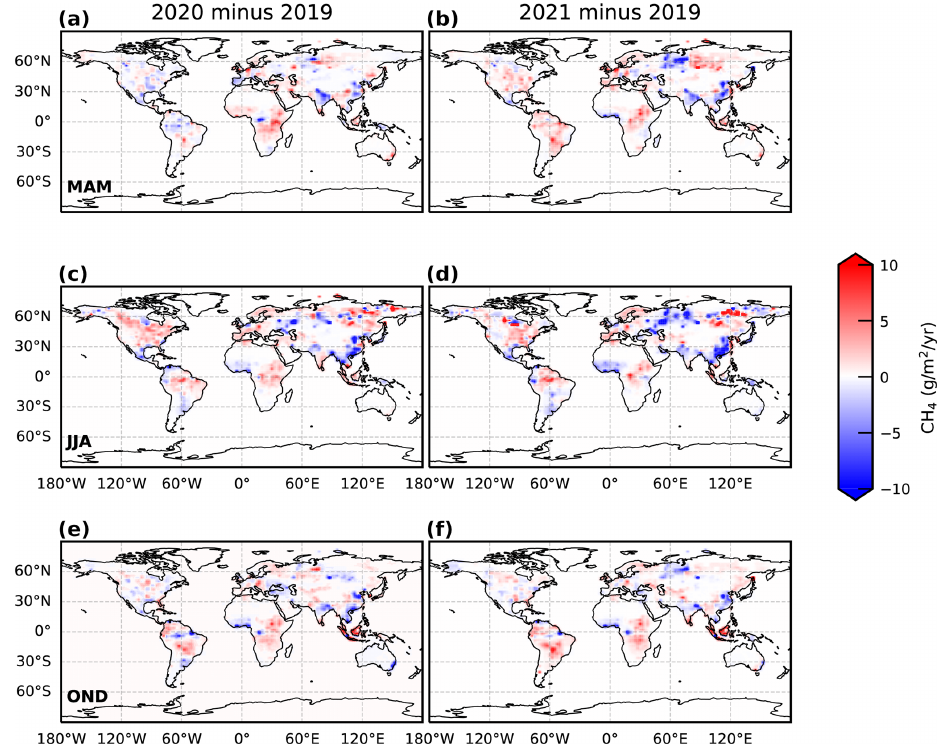
Figure A4. Global seasonal a posteriori emissions of methane (gm − 2 yr − 1 ) inferred from GOSAT methane:CO 2 column ratio data for (a, c, e) 2020 and (b, d, f) 2021 relative to the baseline year of 2019, described in terms of absolute values. Seasons are based on rainfall changes over the tropics.